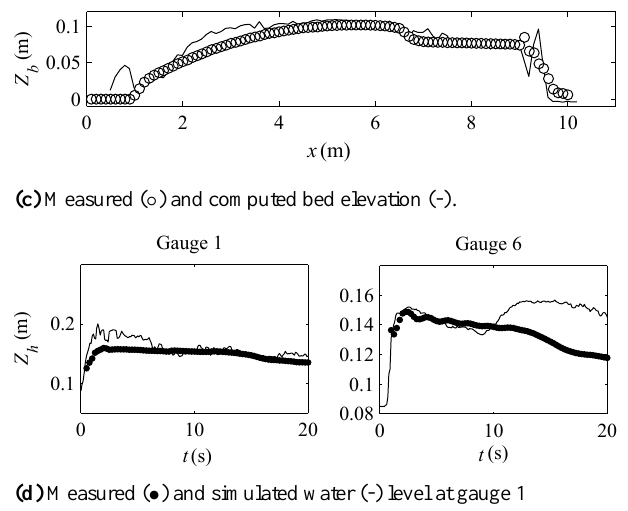
Fig. 4. Numerical and experimental results from the laboratory benchmark